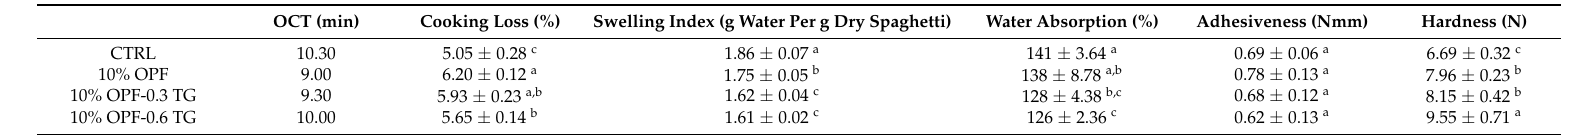
Table 4. Cooking quality of dry spaghetti studied in the Step